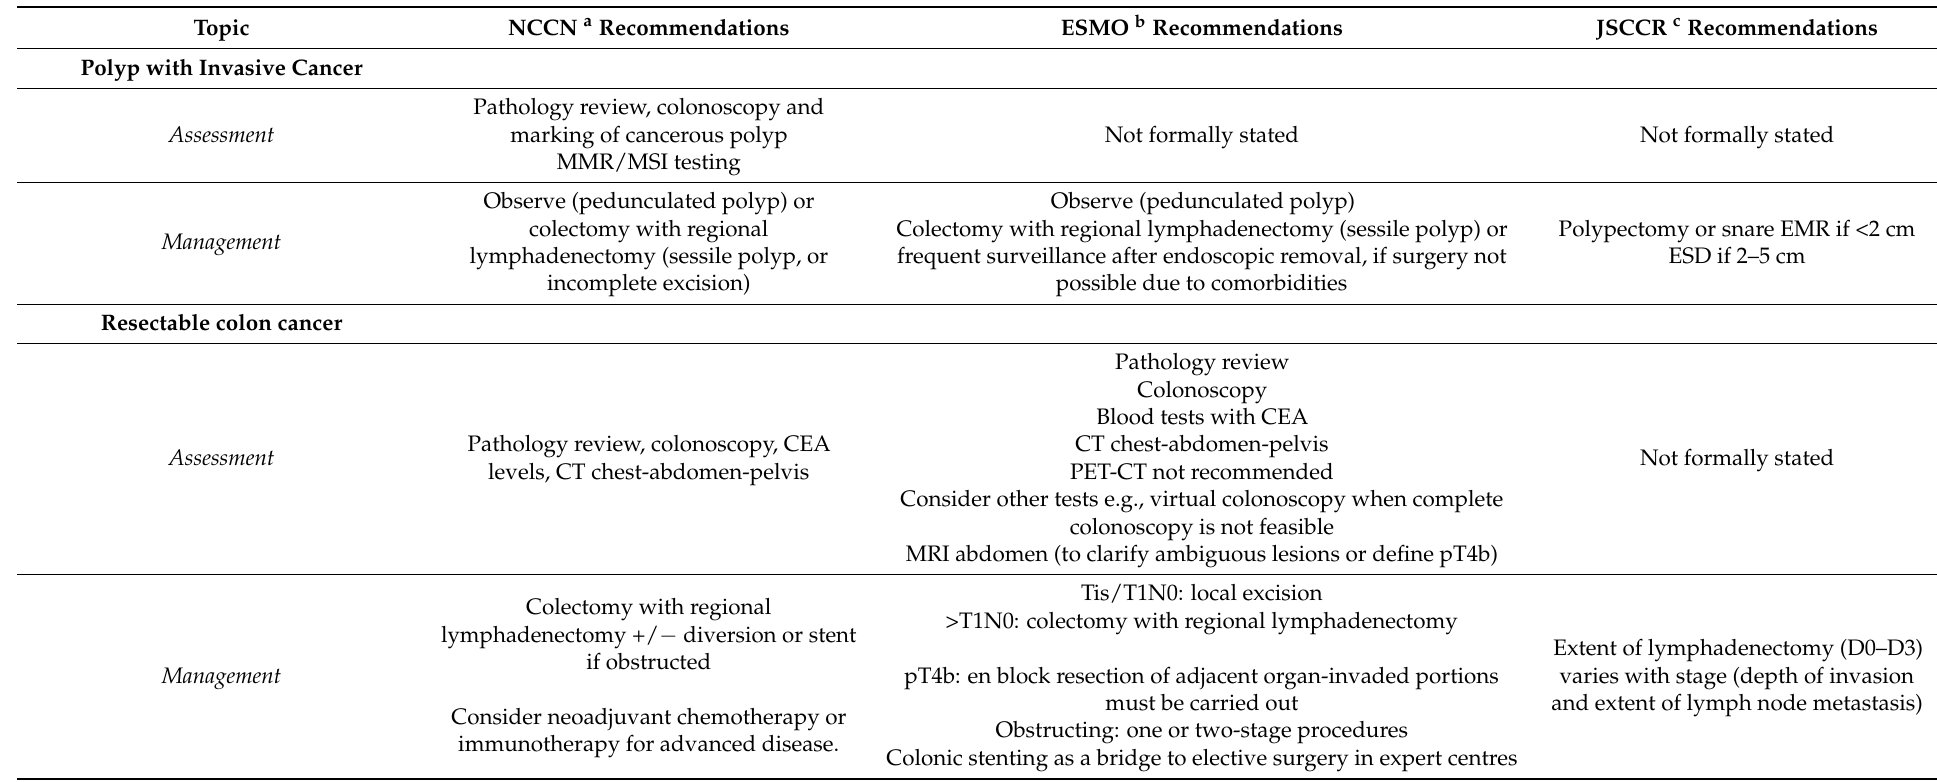
Table 1. Colon cancer: Precancerous lesions and invasive cancer: assessment and